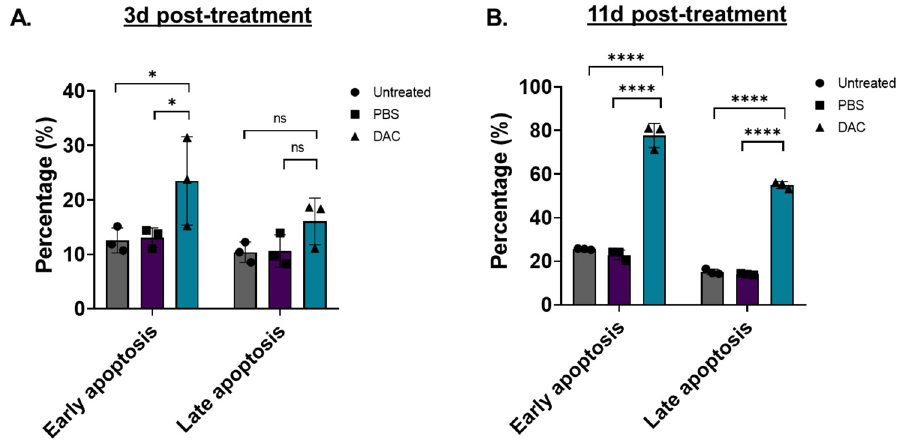
Figure 3. DAC treatment induces early and late apoptosis in HeLa cells. Flow cytometry analysis of HeLa cells stained with Annexin-V (early apoptosis) and 7-AAD (late apoptosis) in response to DAC treatment. Cells were treated with 1 μ M DAC, 72 h, and apoptosis was assessed at 3d ( A ) and 11d post-treatment ( B ). The percentage of early and late apoptotic cells is plotted in response to DAC treatment. The data represent average values from three independent experiments (mean ±